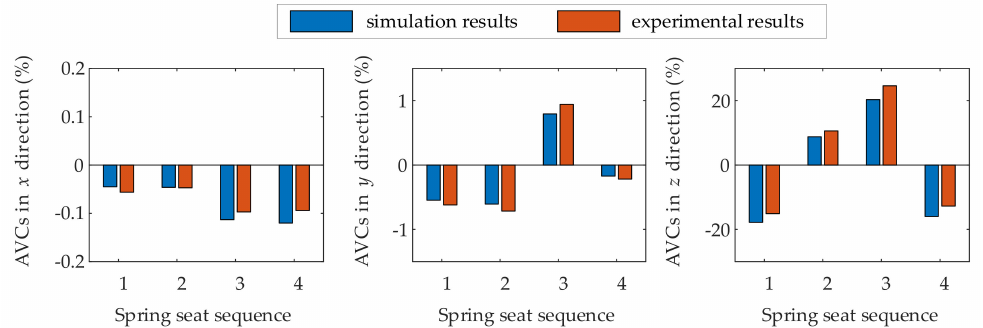
Figure 11. The amplitude variation coe ffi cients (AVCs) of each spring seat in the x , y , and z directions under spring failure kind 2, including the simulation results and experimental results.